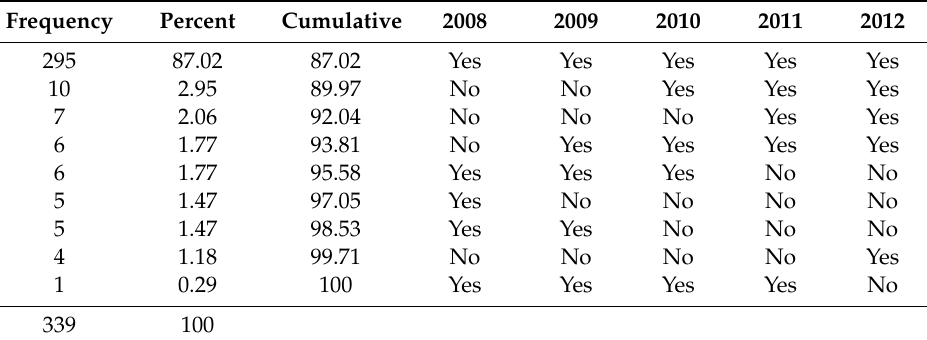
Table A3. Hospital data coverage for unbalanced panel